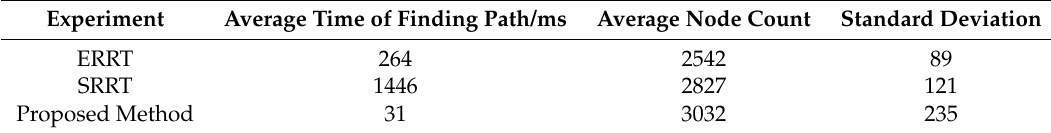
Table 1. Simulation comparison result of three